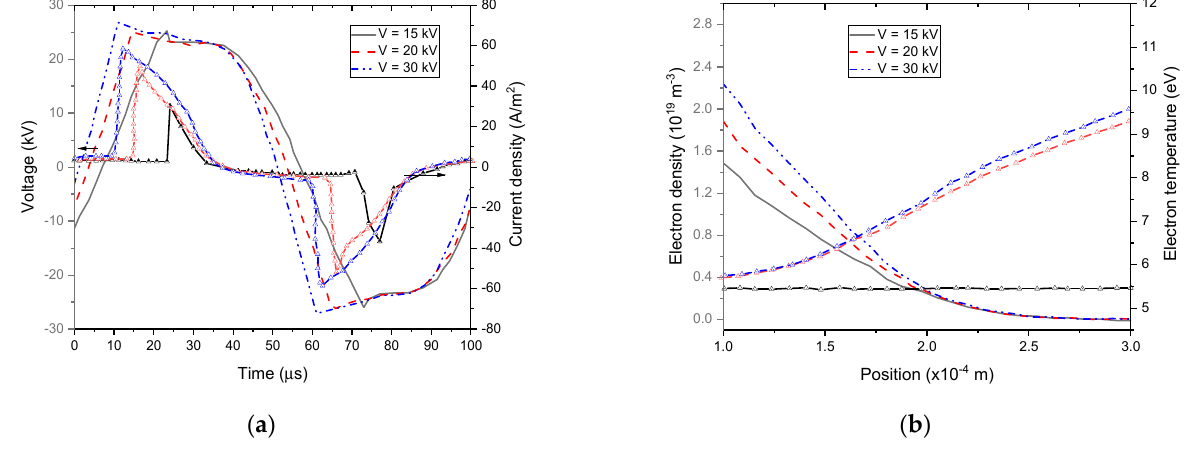
Figure 11. Calculated current density and gas voltage waveforms ( a ) and spatial electron density and temperature distribution at maximum discharge current ( b ) for different external voltages. Figure 10. Time evolution of the total power distribution at x = 0.2 mm (the center of the gap).